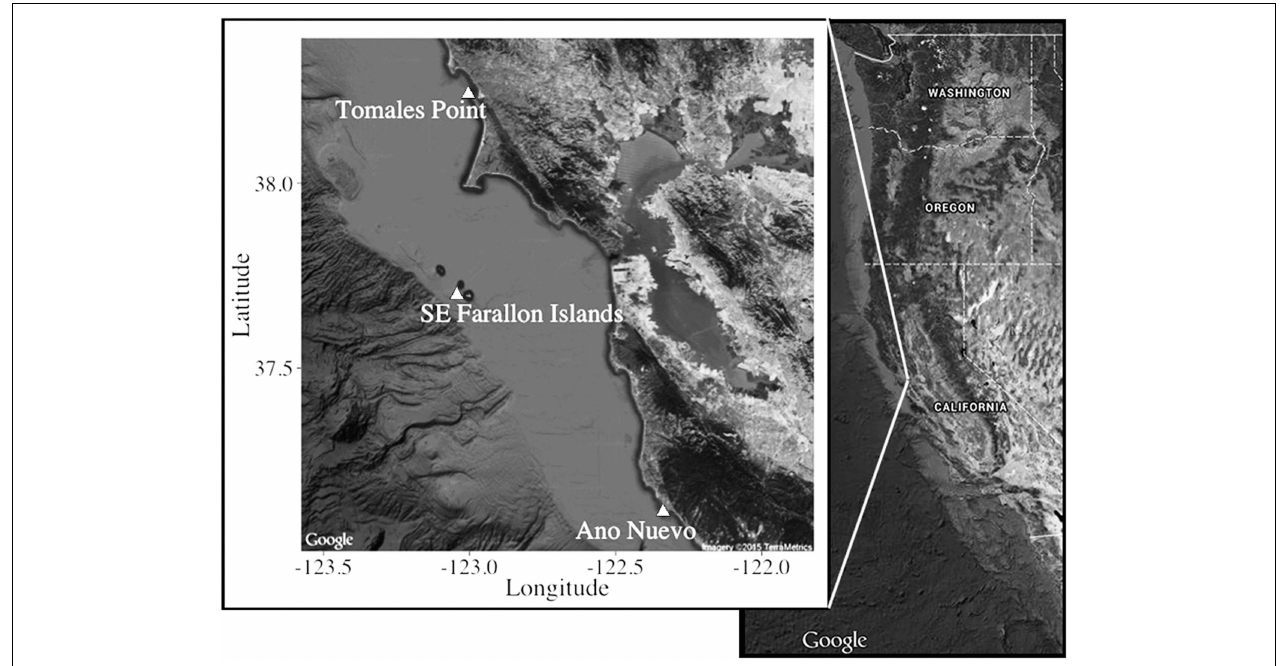
FIGURE 1 | Sampling locations off central